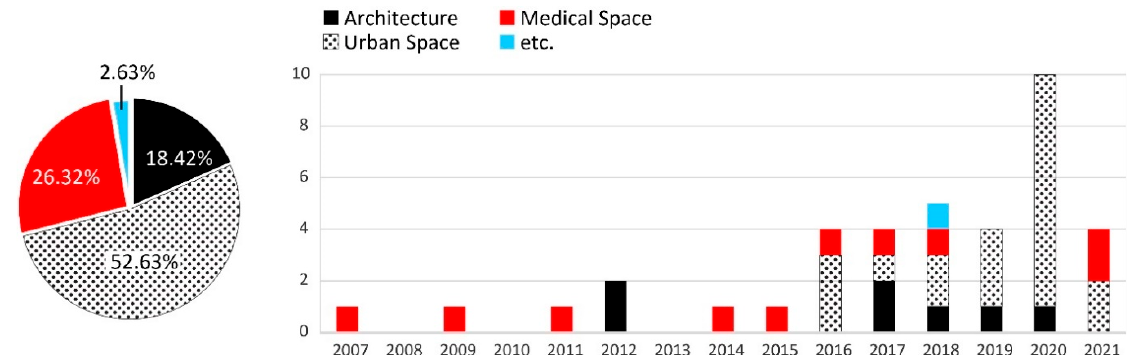
Figure 2. The percentage of articles by research area and the number of articles by publication year.